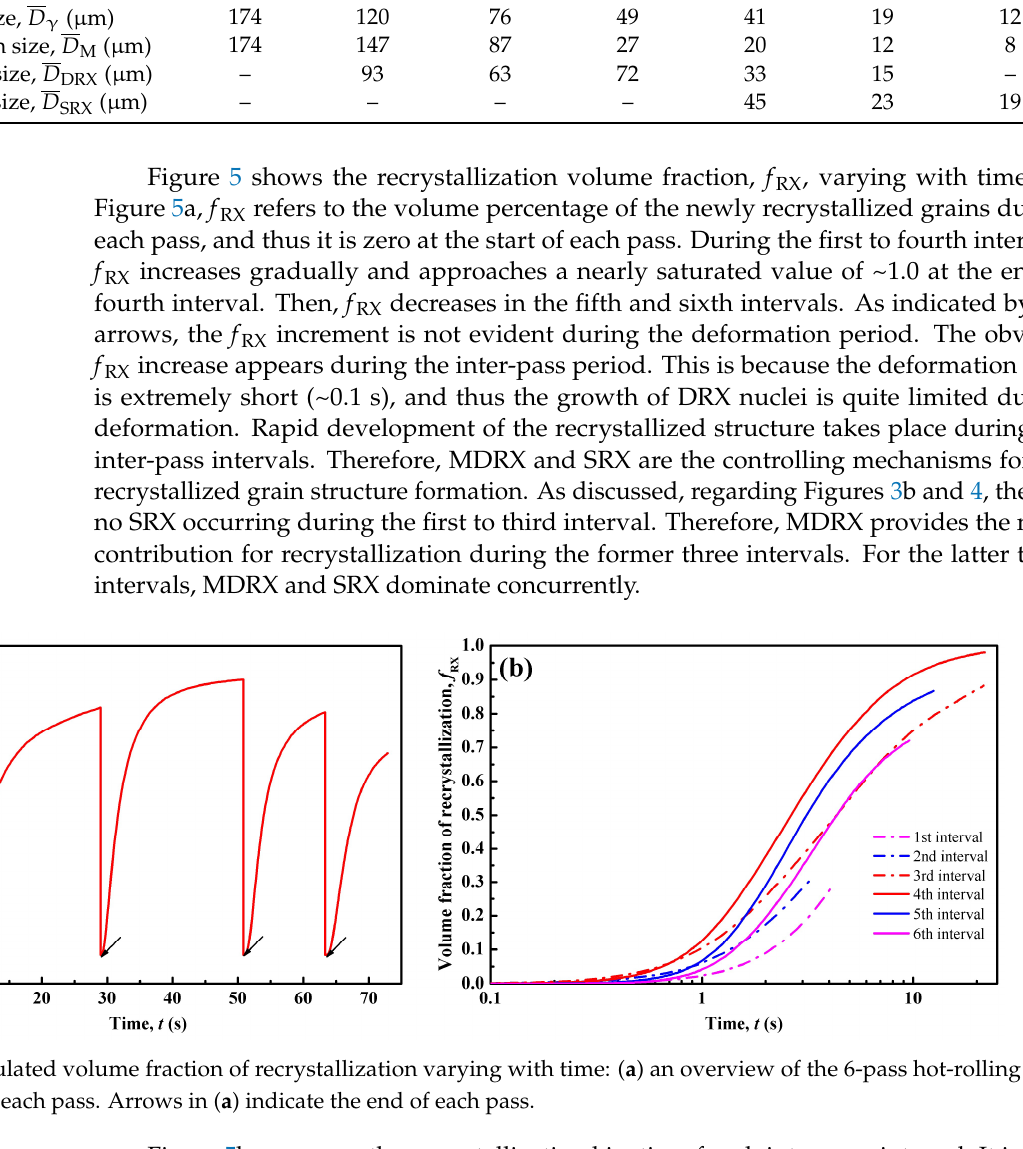
Table 4. Average grain size at the end of each interval.